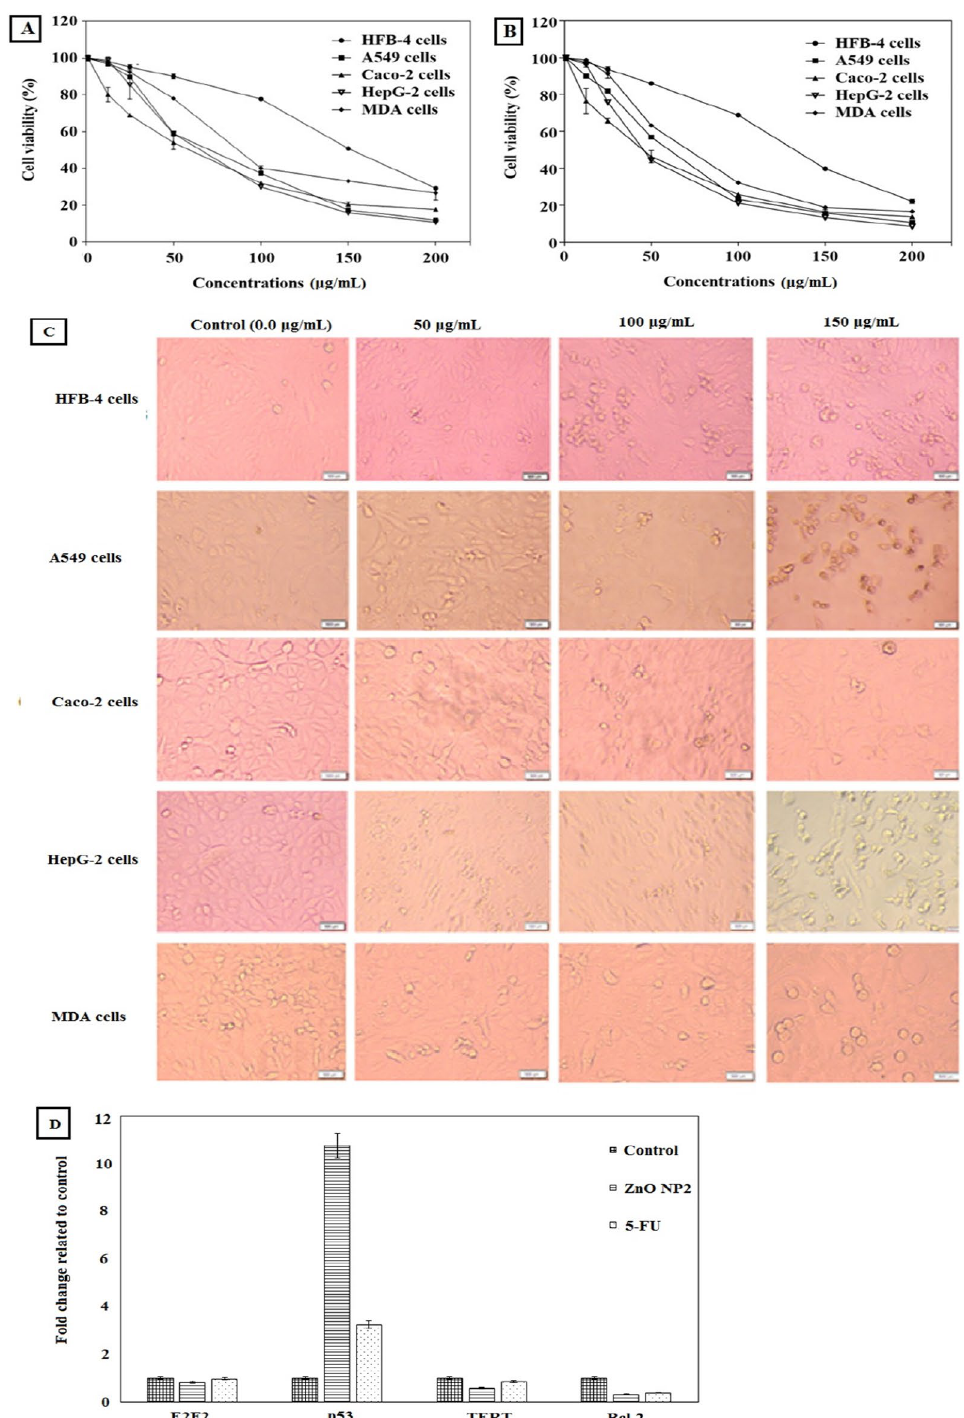
Figure 10. In vitro evaluation of anticancer activity of the prepared ZnO NPs. ( A,B ) Effect of the biosynthetic ZnO NPs at various concentrations (0–200 μg/mL) on the proliferation of normal (HFB-4) cells and tumor (A549, Caco-2, HepG-2, and MDA) cell lines after 24 h and after 48 h of treatment, respectively. ( C ) Effect of the biosynthetic ZnO NPs on morphological changes of normal (HFB-4) cells and different types of tumor cells including A549, Caco-2, HepG-2, and MDA cell lines under phase contrast microscope. Normal and tumor cells were treated with the biosynthetic ZnO NPs at different ratios of 50 μg/mL, 100 μg/mL and 200 μg/mL for 48 h as compared to reference control cells (0.0 μg/mL). ( D ) Effect of the biosynthetic ZnO NPs on relative changes in the expression levels of four key genes in HepG-2 cells after treatment in comparison with 5-FU for 48 h. All values are expressed as mean ± SD and represent the average values from three